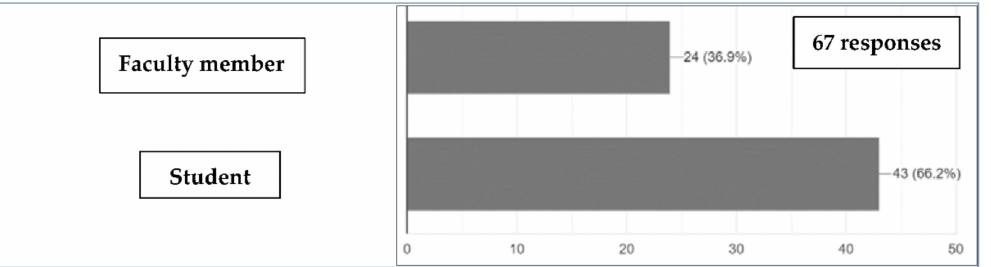
Figure 4. The distribution of the sample between the responses of faculty members and